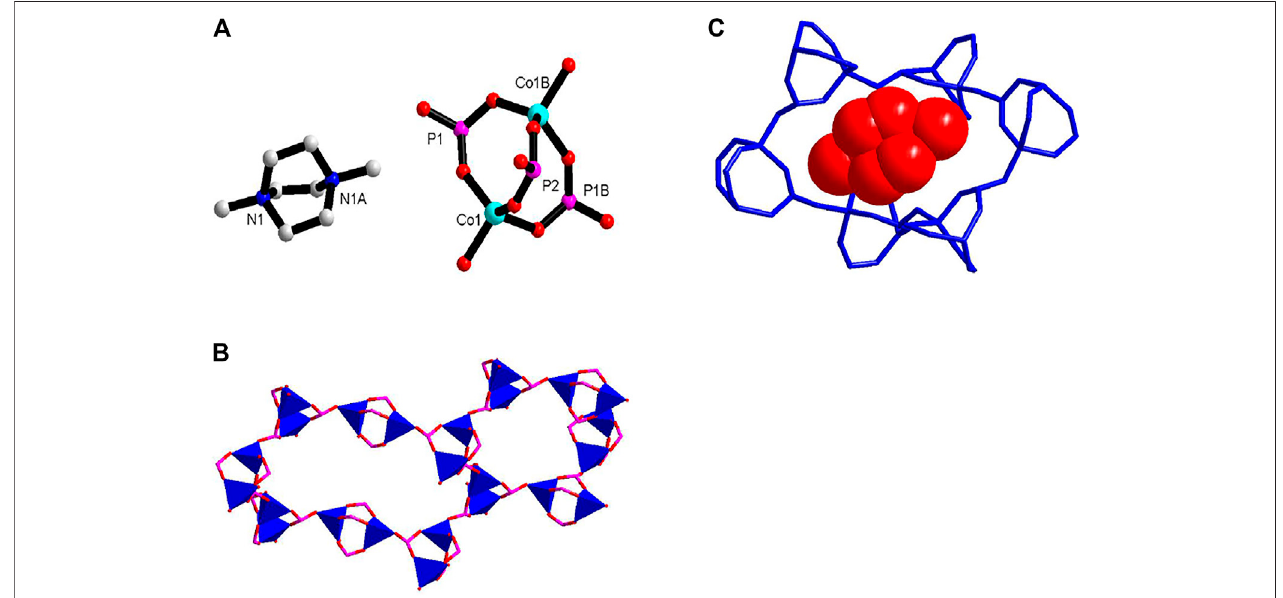
FIGURE1|(A) Thecoordinationgeometryof 1 showing[Co 2 (HPO 3 ) 3 ]SBU; (B) 3Dframework structureshowingtwotypesofchiralnanometer-sized cavities;and (C) close-up of the Me 2 -DABCO rotator in the crystal, shown in the red space fi lling model; rigid stator illustrated in blue